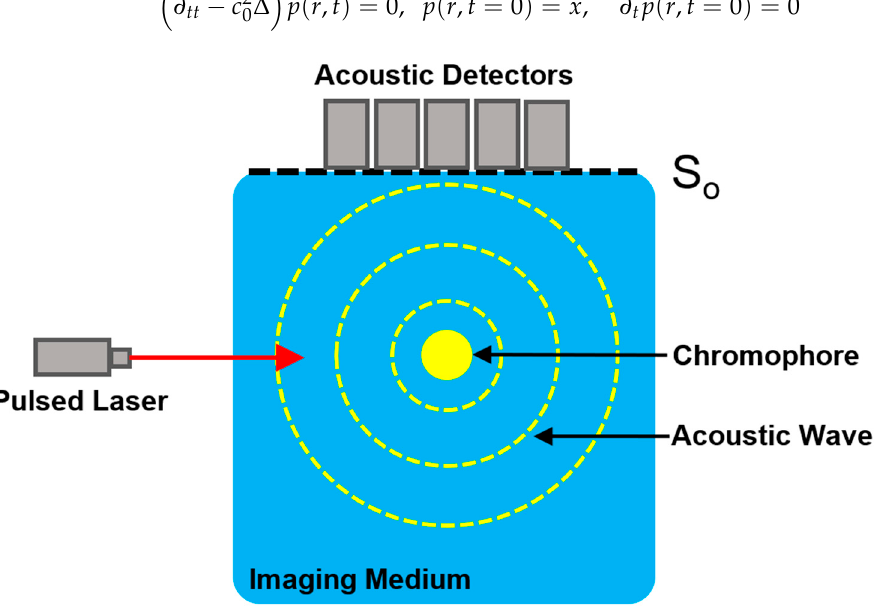
Figure 1. Diagram illustrating the process of photoacoustic signal generation and detection. Chro- mophores absorb the incident pulsed laser light and undergo thermoelastic expansion to generate acoustic waves. Acoustic detectors along the measurement boundary So are used to measure the acoustic waves.